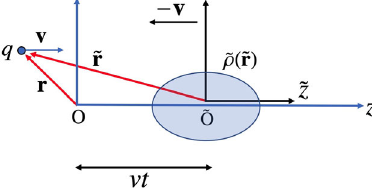
FIG. 5. Coordinate system for single particle of velocity v colliding with the charge density function ρ with velocity − v